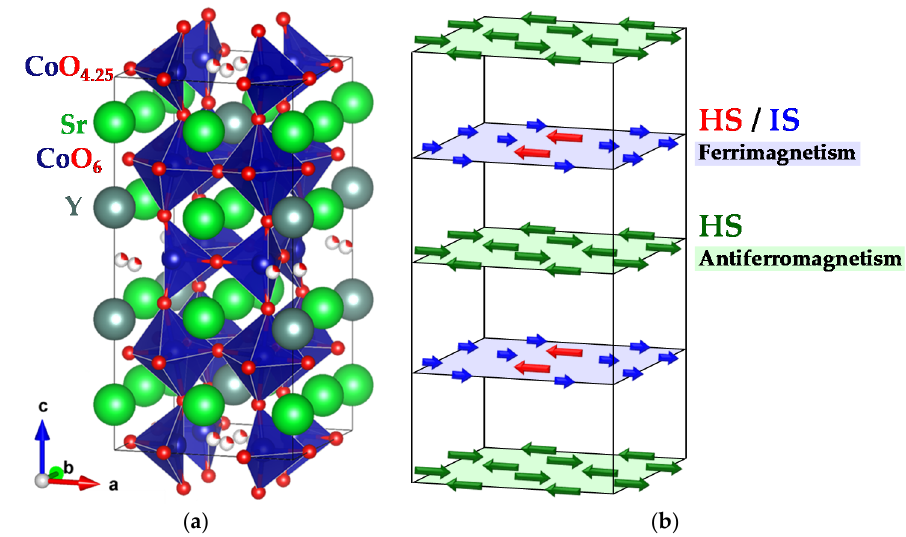
Figure 1. ( a ) Crystal structure and ( b ) magnetic structure of Sr 3.1 Y 0.9 Co 4 O 10.5 .